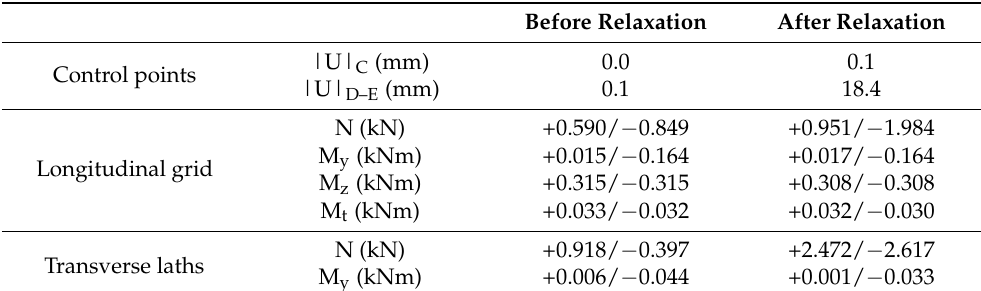
Table 9. Model A (with semi-rigid connections). Displacements at control points C and D–E and maximum axial forces and moments due to the construction process, before relaxation ( Stage 4 ) and after relaxation ( Stage 5 ). Before Relaxation After Relaxation Control